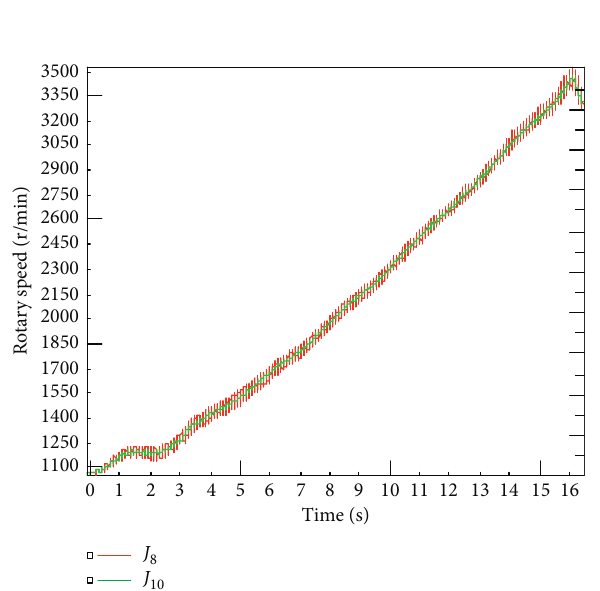
Figure 35: The 2 nd order angular acceleration curve of the input shaft of the gearbox matching the DMF with the bifilar CPVA under driving